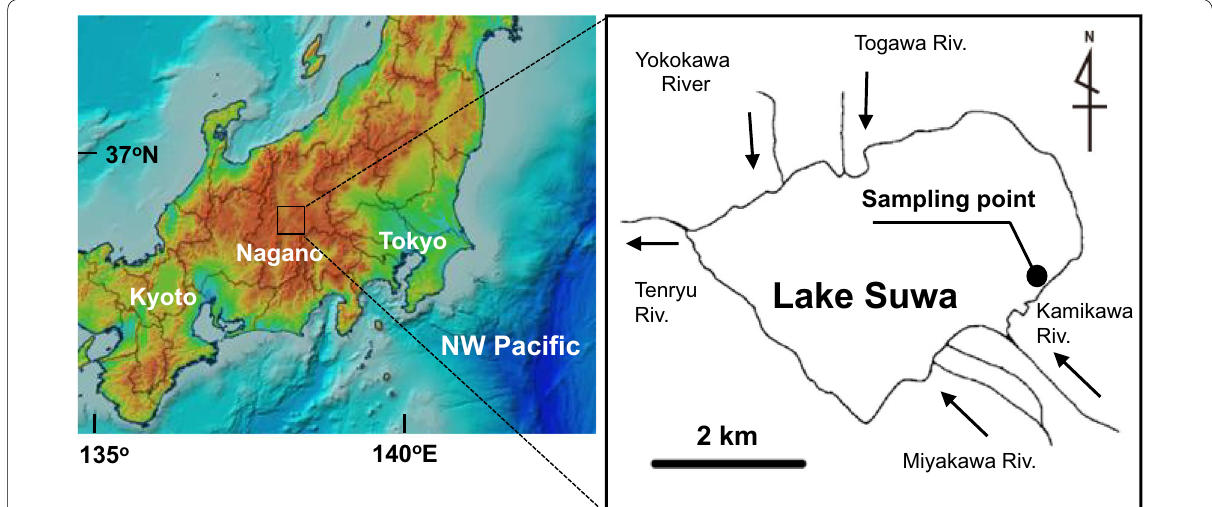
Fig. 1 Map of the study site location. Lake Suwa is located in the central part of Honshu Island, Japan (36°2 ′ 46.92 ″ N, 138°6 ′ 30.94 ″ E). Samples were collected along the southeastern shore of Lake